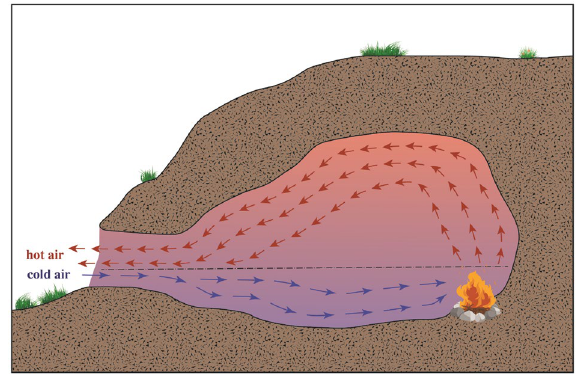
Figure 1. Smoke dispersal in a cave. Smoke is emitted towards the ceiling in the direction of the cave opening. The arrows represent air circulation, and the broken line represents the balance point between the cold and hot air flows (taken from 62